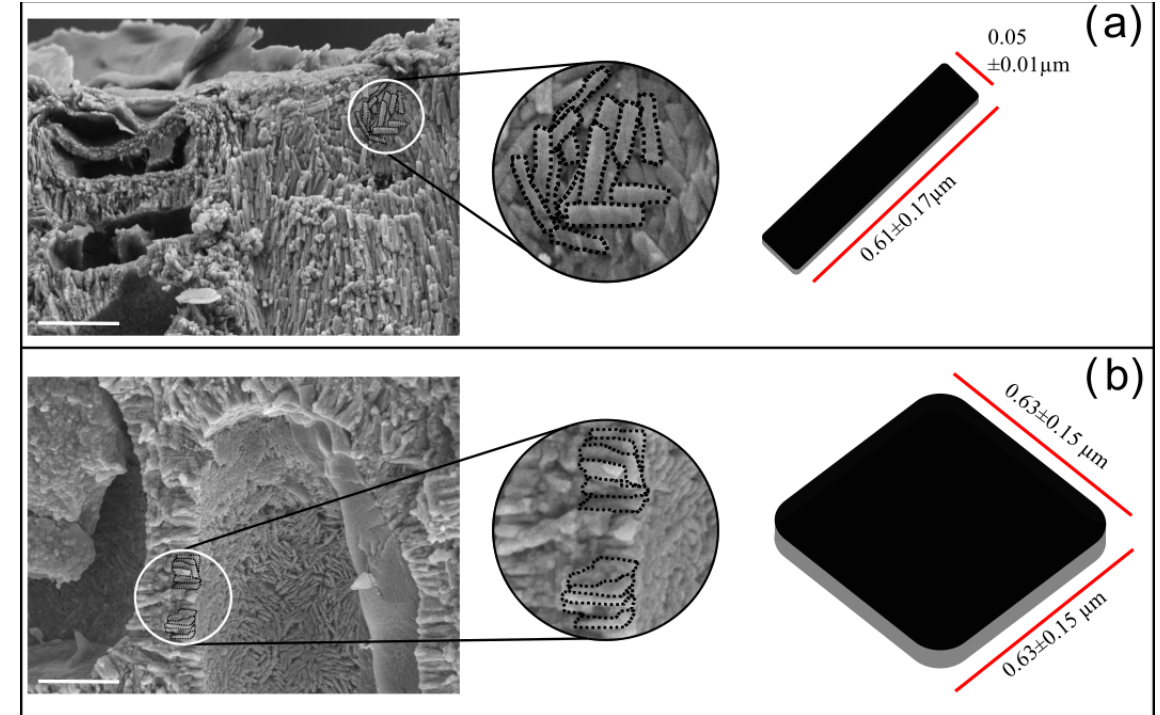
Figure 6. Ultrastructures of Lithothamnion corallioides : (a) rectangular tiles of the PW; (b) squared bricks of